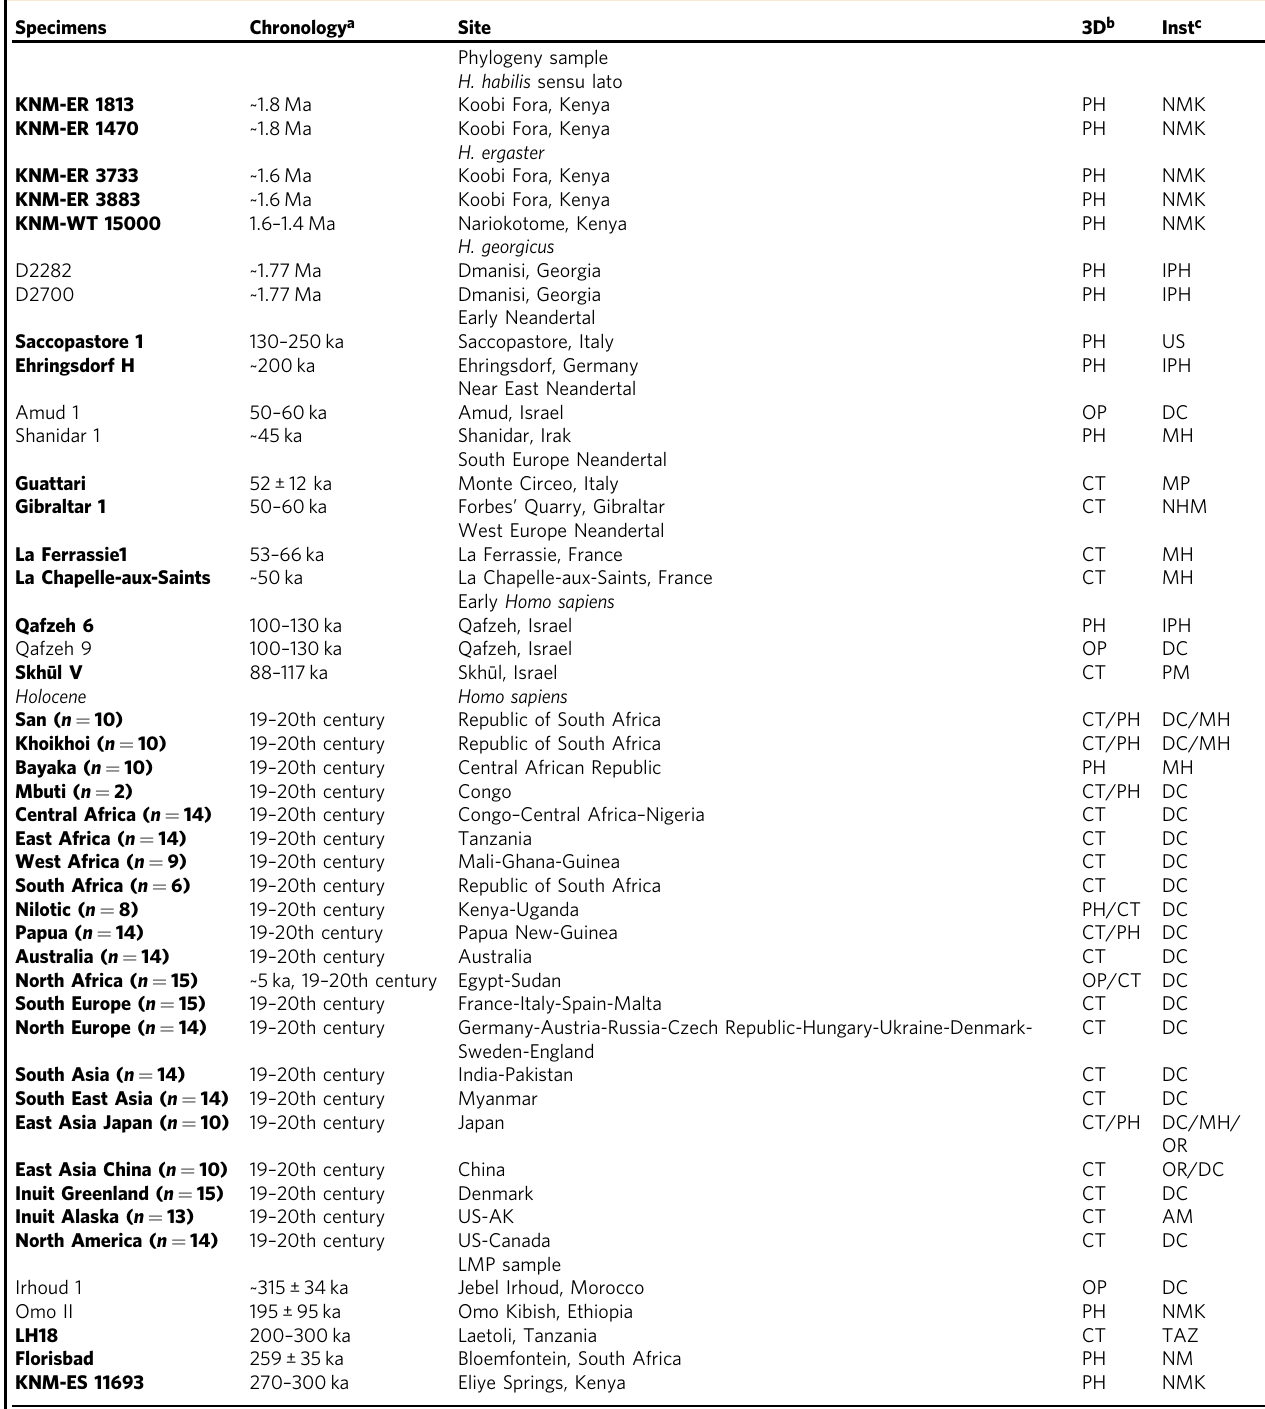
Table 1 Specimens included in the study